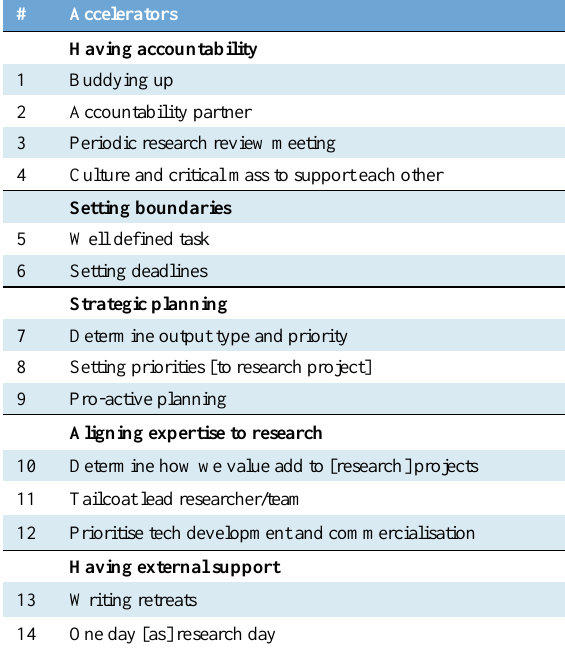
Table 4. Research process and production